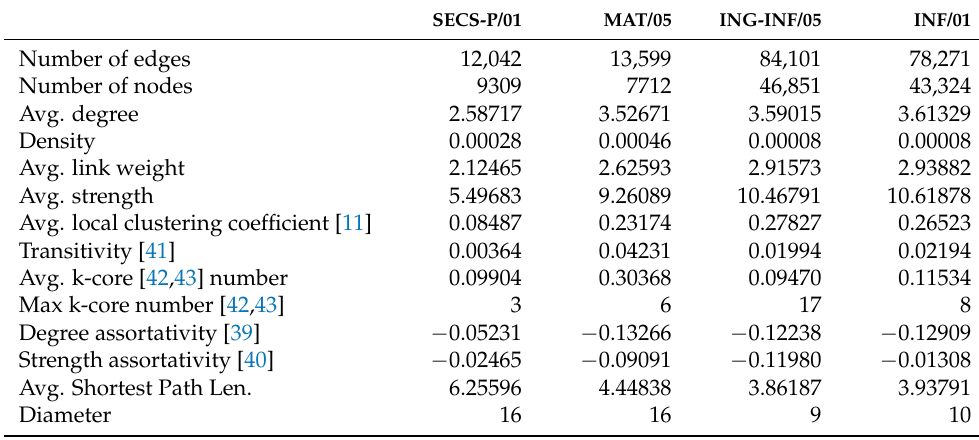
Figure 2. These figures highlight the core of co-authorship networks (orange/clear) with respect to direct coauthors (blue/darker). Table 4. Characteristics of the Largest Connected Component of the Depth 1